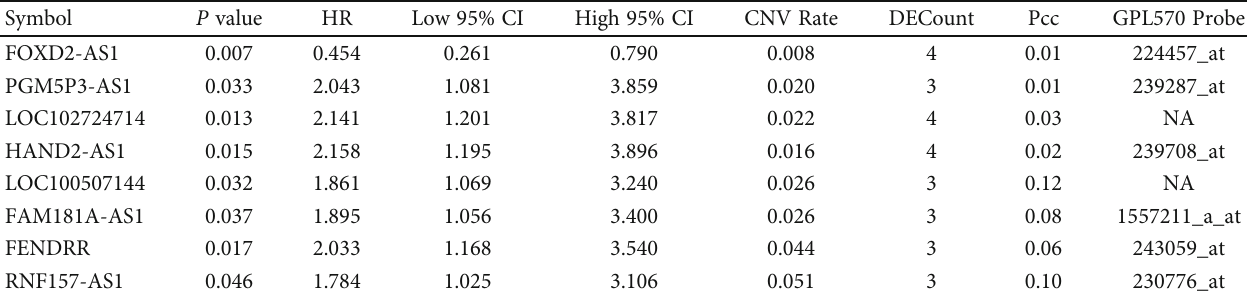
Table 4: LncRNAs with signi fi cant